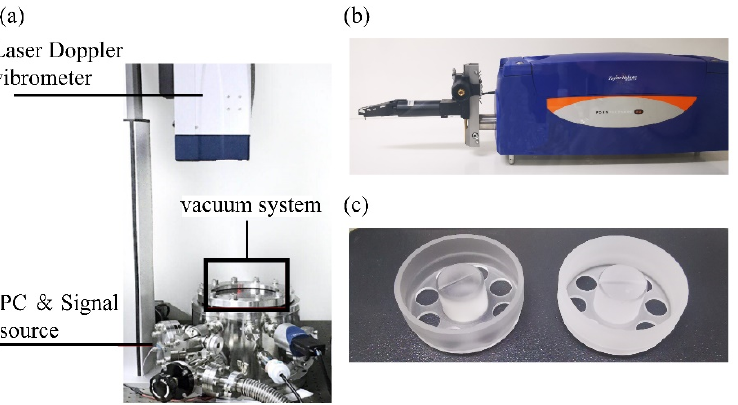
Figure 1. ( a ) The schematic of the measurement system. ( b ) The schematic of the profilometer. ( c ) The schematic of the cylindrical resonator structure. Table 1. Grinding speeds of